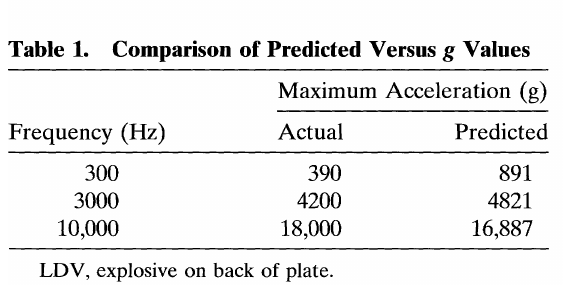
LDV, explosive on back of